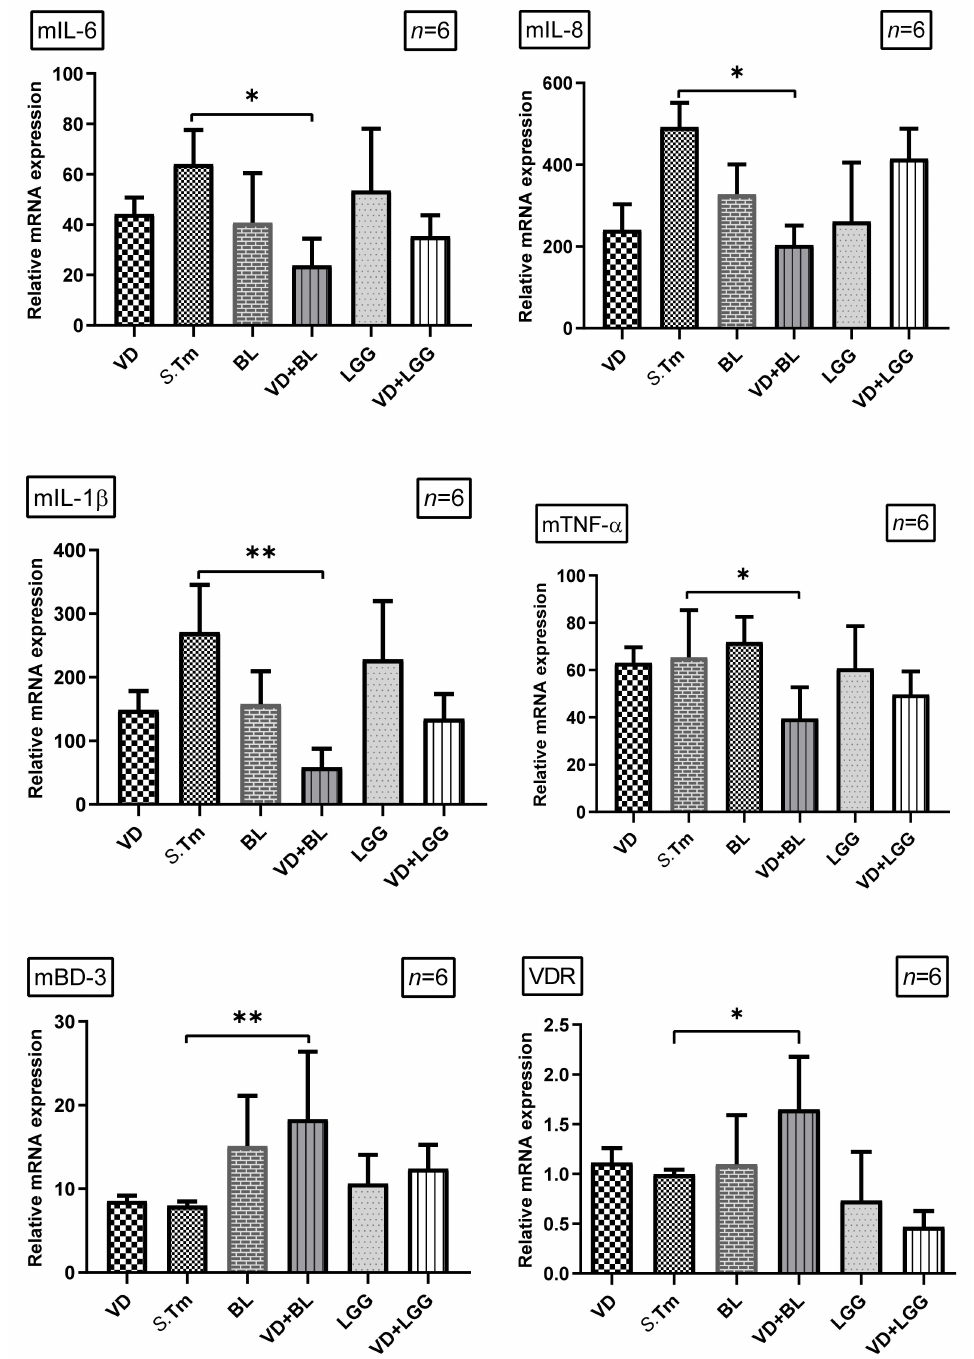
Figure 2. The immunoregulatory effects of combined 1,25D3 and Bifidobacterium Longum on cecal cytokines and antimicrobial peptide in Salmonella colitis mice. Before and after infection, mice were gavaged with vehicle control (5% dimethyl sulfoxide), 1,25D3 (VD), Lactobacillus rhamnosus GG (LGG) or Bifidobacterium longum (BL), or combination of VD and BL (VD+BL) or LGG (VD + LGG). At the end of the experiment, total RNA was extracted from the cecal tissues. mIL-6 mIL-8, mIL-1 β , mTNF- α , mBD-3 and VDR mRNA expressions were analyzed using real-time quantitative PCR. Values were measured as fold increase compared to the level of control group. The data shown are means ± the SEM ( n = 6 mice/group). An asterisk indicates the significant differences compared to Salmonella infection only group, based on one-way ANOVA. * p < 0.05, ** p <